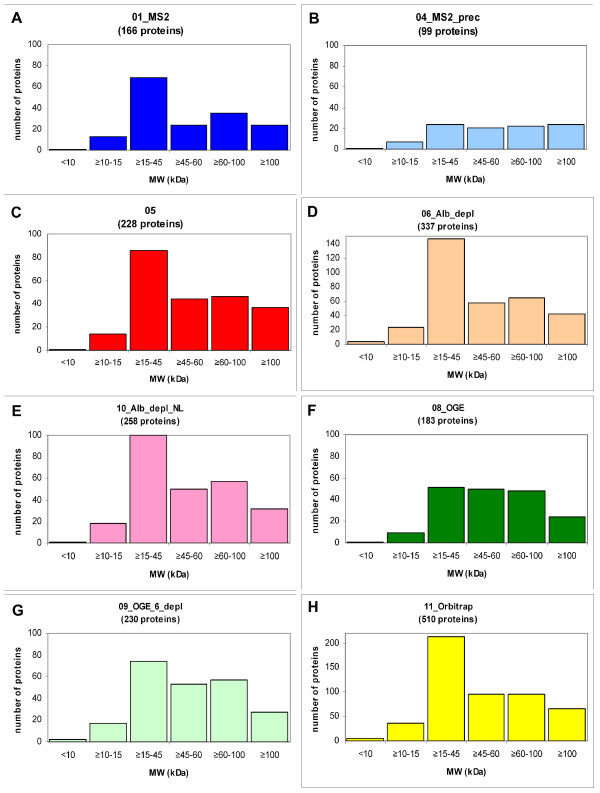
Histograms depicting the molecular weight distribution of the identified proteins in each of the 8 experiments. The proteins from each individual experiment were grouped according to their calculated molecular weight and plotted as indicated. All Y-axis scales except for the ones in panels D and H have been standardized to facilitate cross-experiment comparison.